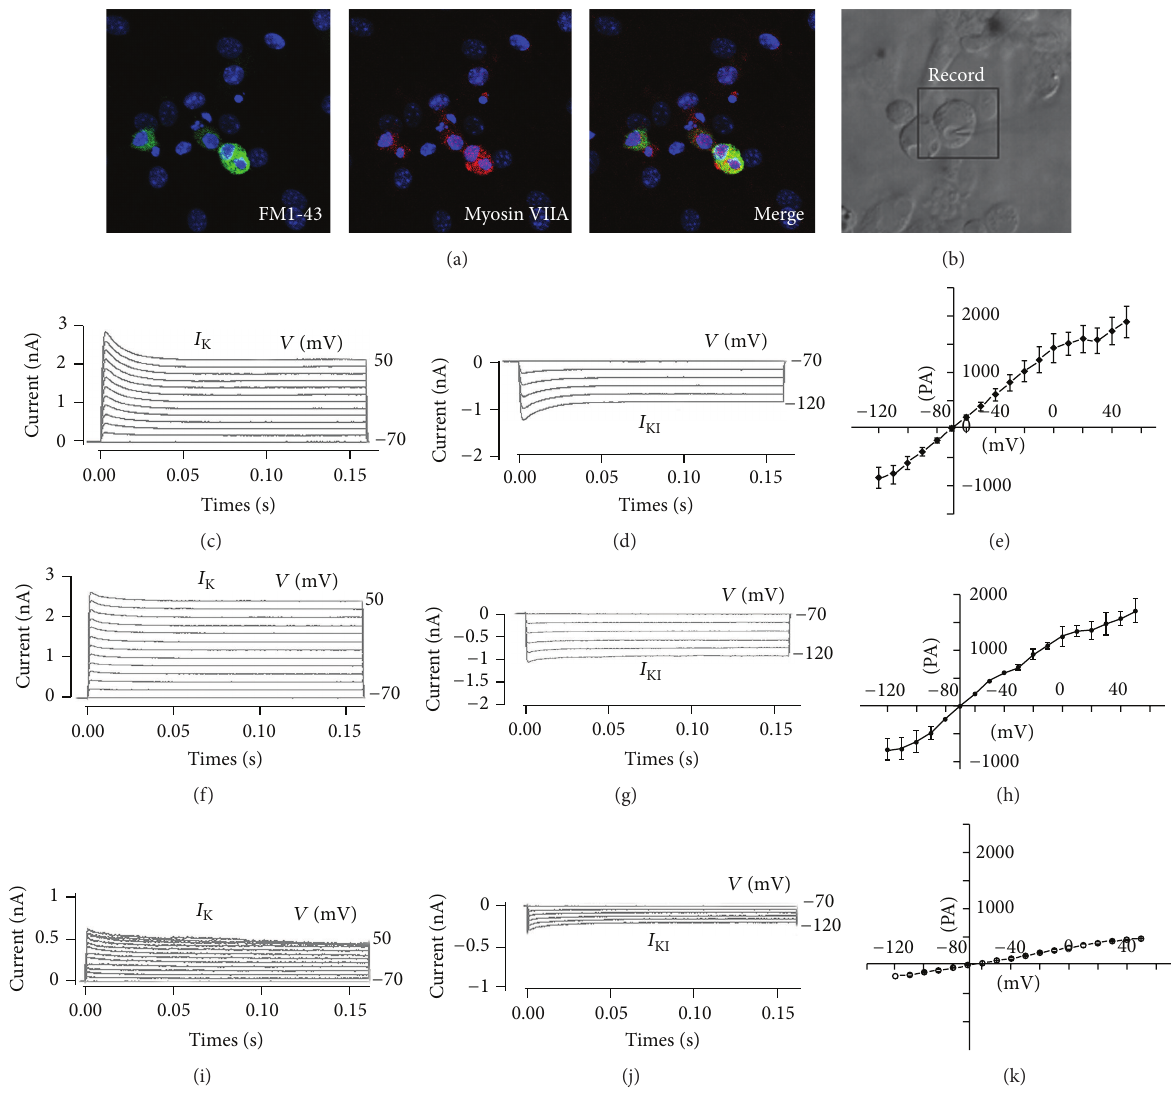
Figure 6: Voltage-dependent currents elicited from inner ear multipotent-cell-derived FM1-43FX-positive cells. FM1-43FX-positive cells were voltage clamped at − 84mV and stepped between − 120 and 50 mV in 10 mV increments. 10 out of 18 cells tested had positive responses and expressed the similar outward and inward K + currents. (a) FM1-43FX-positive cells (green, left) coexpressed the hair cell marker Myosin VIIA (red, center). (b) White light image of a recording electrode on an FM1-43FX-positive cell. (c) Outward K + currents recorded from hair- cell-like cells. (d) Inward K + currents recorded from hair-cell-like cells. (e) Average current-voltage ( I-V ) curve for the outward and inward K + current measured of hair-cell-like cells at the steady-state level (100–160ms). (f) Outward K + currents recorded from neonatal mouse cochlea hair cells. (g) Inward K + currents recorded from neonatal mouse cochlea hair cells. (h) Average current-voltage ( I-V ) curve for the outward and inward K + current of neonatal mouse cochlea hair cells measured at the steady-state level (100–160ms). (i) Outward K + currents recorded from the cells that are not hair cells. (j) Inward K + currents recorded from the cells that are not hair cells. (k) Average current-voltage ( I-V ) curve for the outward and inward K + current of the cells that are not hair cells measured at the steady-state level